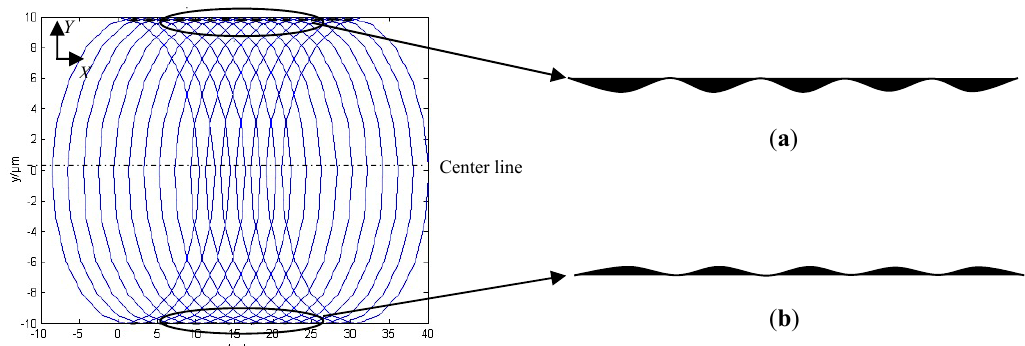
Figure 3. The micro groove surface topography without considering total radial run out. ( a ) Up milling. ( b ) Down milling.